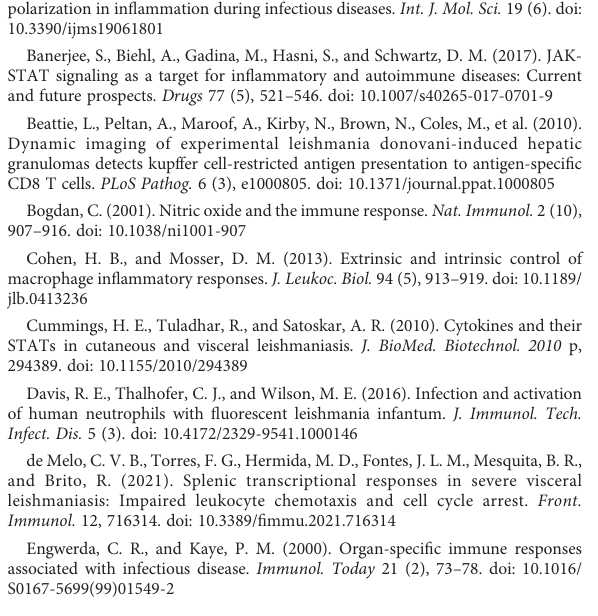
SUPPLEMENTARY TABLE 1 Primers used in the study. SUPPLEMENTARY FIGURE 1 The effect of EVs derived from L. donovani - or S. Typhimurium -infected macrophages on TNF-alpha release. RAW 264.7 macrophages were infected with L. donovani (72 hpi) or S. Typhimurium (MOI 5:1, 24 hpi). The EVs obtained fromthese cells wereused to treat primarymacrophages for24hours.Media(Ctrl)orEVsfromuninfectedcellswereusedasnegative controls, and LPS treatment 100 ng/mL was used as a control treatment. The cell culture supernatants were collected and processed for anti-TNF- alpha ELISA. One-way ANOVA for multiple comparison tests was used to establishstatistical signi fi cance. N=3.Exo (-),EVsfromuninfected cells; Exo ( Ld ), EVs from cells infected with L. donovani; Exo ( St ), EVs from cells infected with S. Typhimurium; Exo ( St ) dis, disrupted EVs from cells infected with S. Typhimurium, Ctrl, cells not